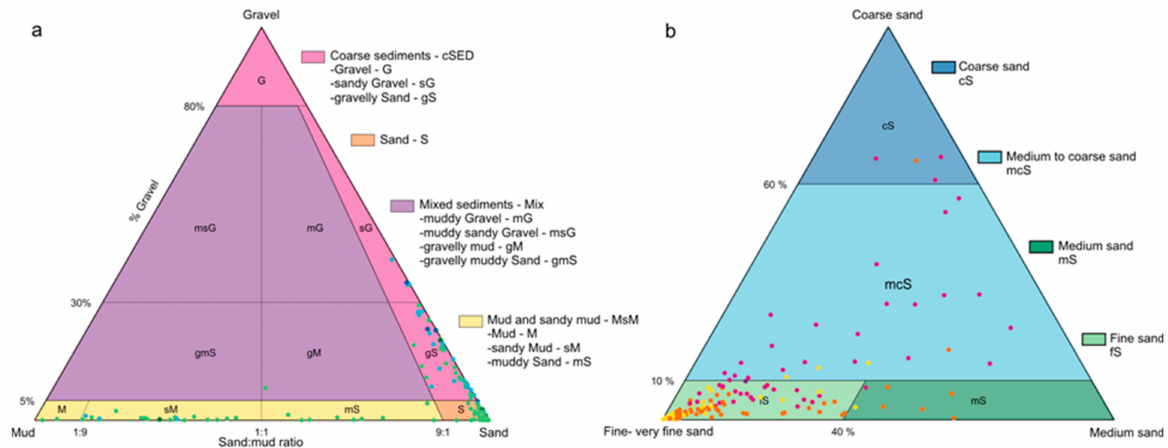
Figure 6. Samples classification according to ( a ) Folk [20] simplified to four classes [21], and to ( b ) Figge [12] showing the wide presence of sandy sediments with a variable content of mud and coarse sediments. The sand fraction of muddy and sandy sediments mainly consists of fine sand; coarse sediments include medium and coarse sands. Colours of points refer to the legends of the